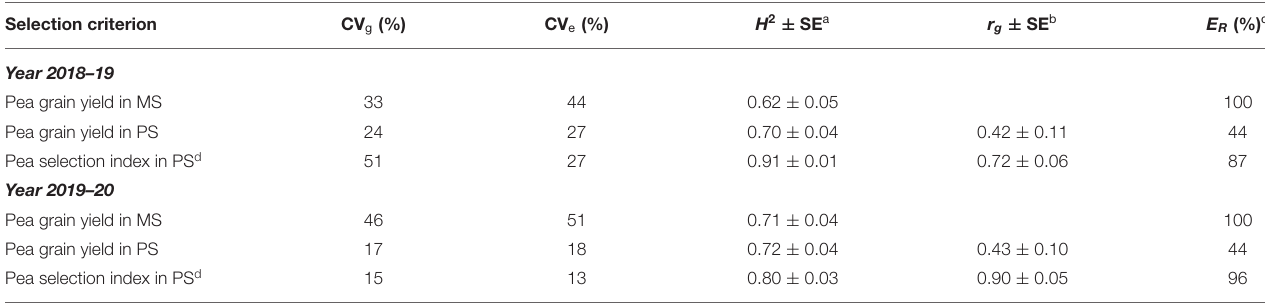
TABLE 3 | Genetic (CV g ) and experiment error (CV e ) coefficient of variation and broad-sense heritability on a line mean basis ( H 2 ) for pea direct selection for grain yield in mixed stand with cereals (MS) and pea indirect selection for yield in MS based on yield or a pea selection index in pure stand (PS), genetic correlation ( r g ) between direct and indirect selection criteria, and predicted efficiency ( E R ) of indirect selection criteria in PS relative to direct selection in MS, based on data of 144 pea inbred lines in each of two cropping years.